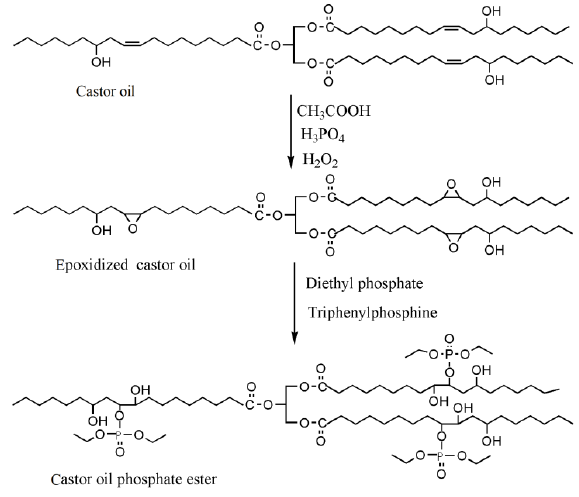
Figure 11. Synthesis of epoxidized cardanol ethyl phosphate.